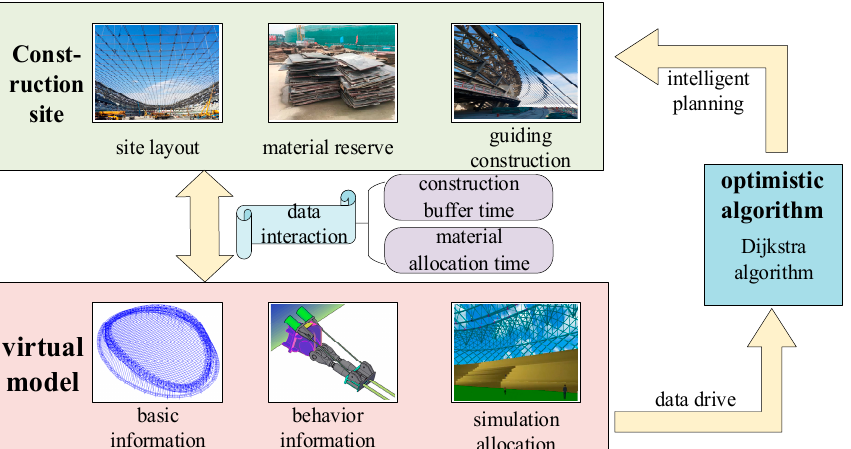
Figure 2. Intelligent planning method of material-allocation path driven by DTs.